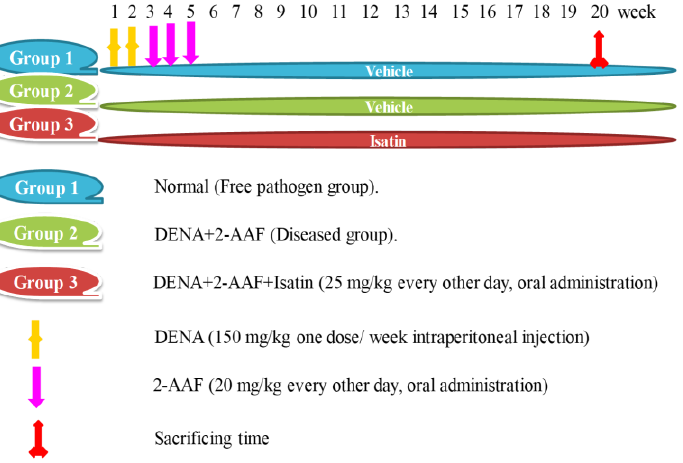
Figure 1. Illustration of the animal grouping and experimental design.